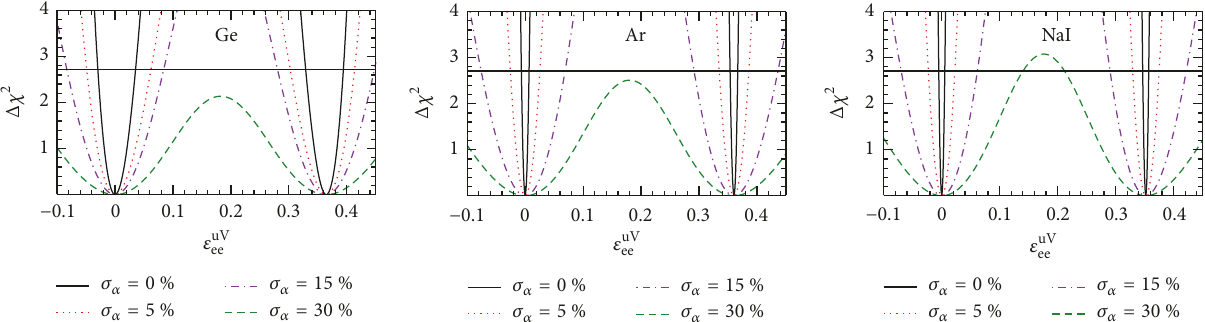
Figure 4: Expected sensitivity to 𝜀 𝑢𝑉 𝑒𝑒 for thedifferent detectors under consideration: Germanium, Argon, and NaI, respectively. As in previous cases, the different curves are for the ideal case of 𝜎 𝛼 = 0 % with 100 % efficiency and a background error of 𝜎 𝛽 = 0 % (solid), for 𝜎 𝛼 = 5 % with 50 % efficiency and a background error of 𝜎 𝛽 = 10 % (dotted), for 𝜎 𝛼 = 15 % with 100 % efficiency and a background error of 𝜎 𝛽 = 10 % (dashed-dotted), and 𝜎 𝛼 = 30 % with 100 % efficiency and a background error of 𝜎 𝛽 = 10 % (dashed); see text for details. The horizontal line indicates the 90 % CL.